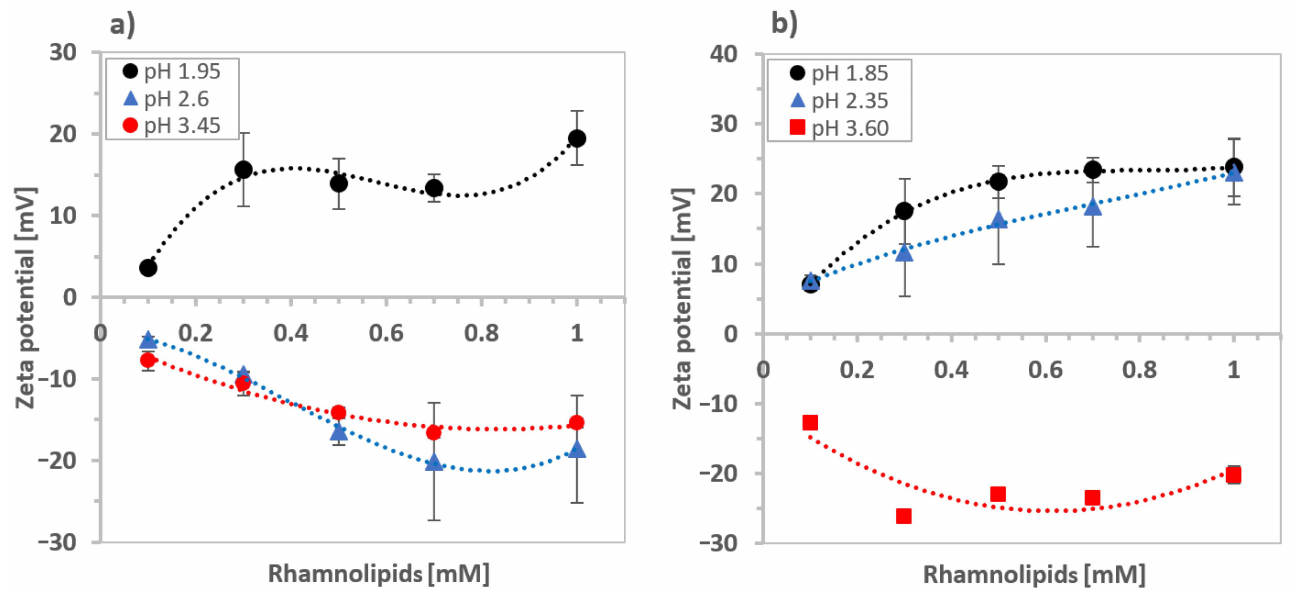
Figure 7. The zeta potential of ( a ) As waste in the presence of rhamnolipids and ( b ) scorodite in the presence of